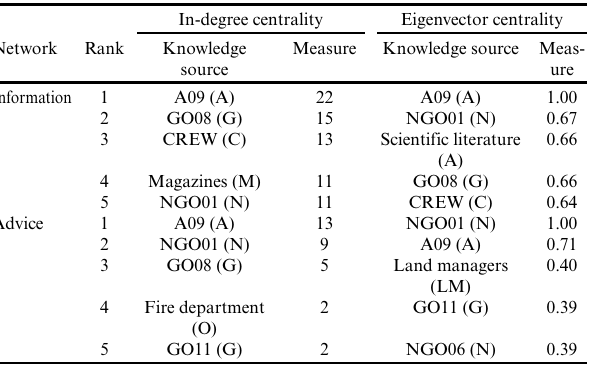
Table 4. Central knowledge sources in the two knowledge networks, ranked by two different centrality measures. Uppercase letters in parentheses and knowledge-source pseudonyms indicate the stakeholders’ associated cluster: A = academia, C = citizen scientist, GO = governmental organization, M = media, NGO = nongovernmental organization, O = other.